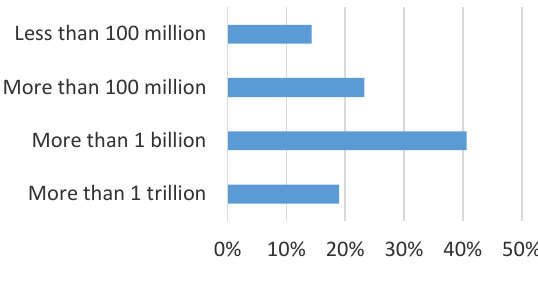
Figure 1: Typical number of points for point clouds encountered by users in practice. Preliminary results extracted from user responses to the OGC survey regarding the current state of standards and best practices in the management of point cloud data.